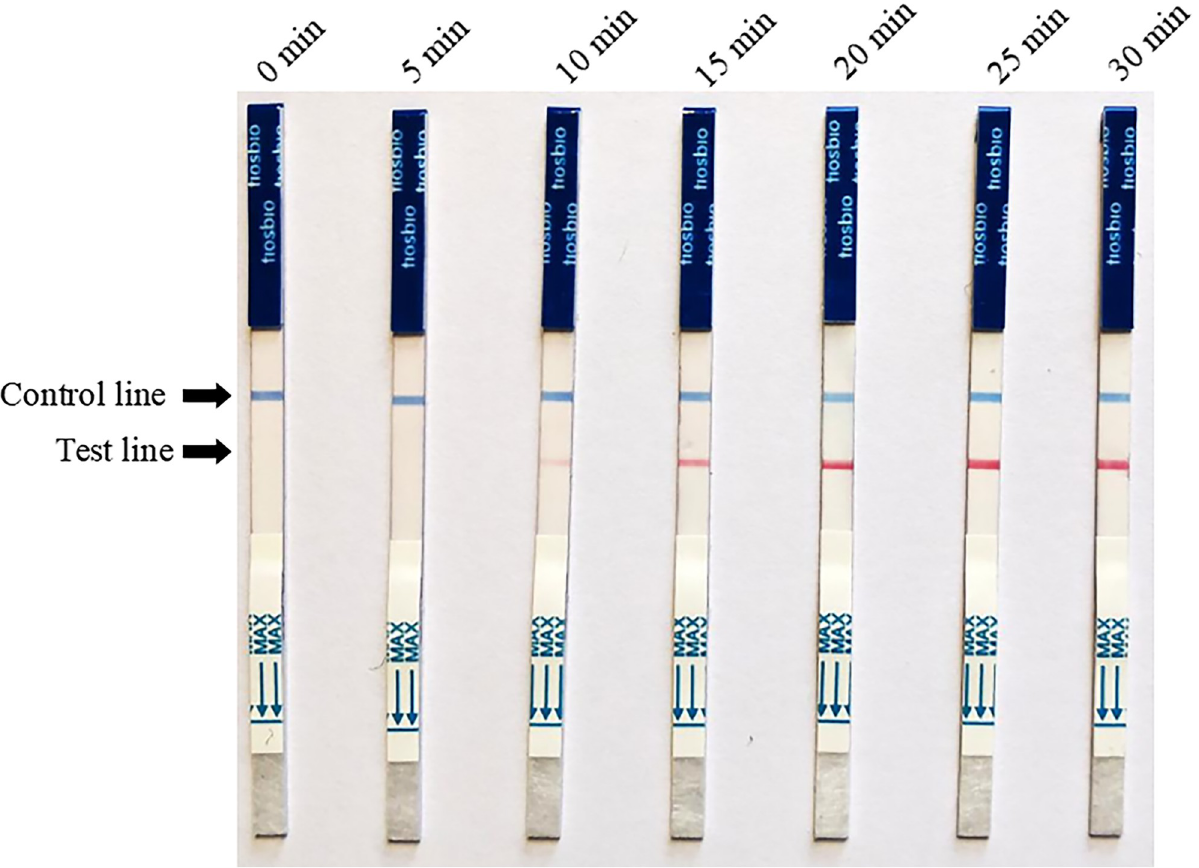
Fig 3. Optimization of reaction time for recombinase polymerase amplification combined with lateral flow test. A darkened test line indicates a positive result.